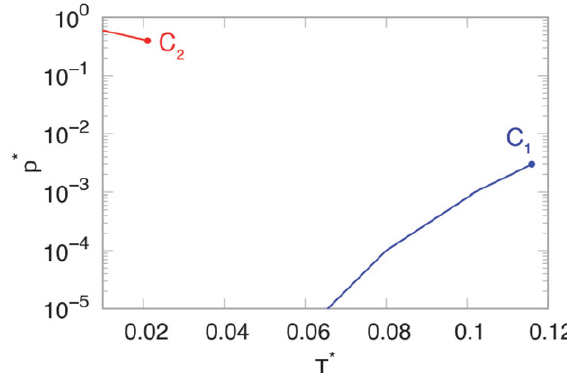
Figure 8: Phase diagram of the noncrystalline phases of water. Red line is liquid-liquid and blue line liquid-gas coexistence